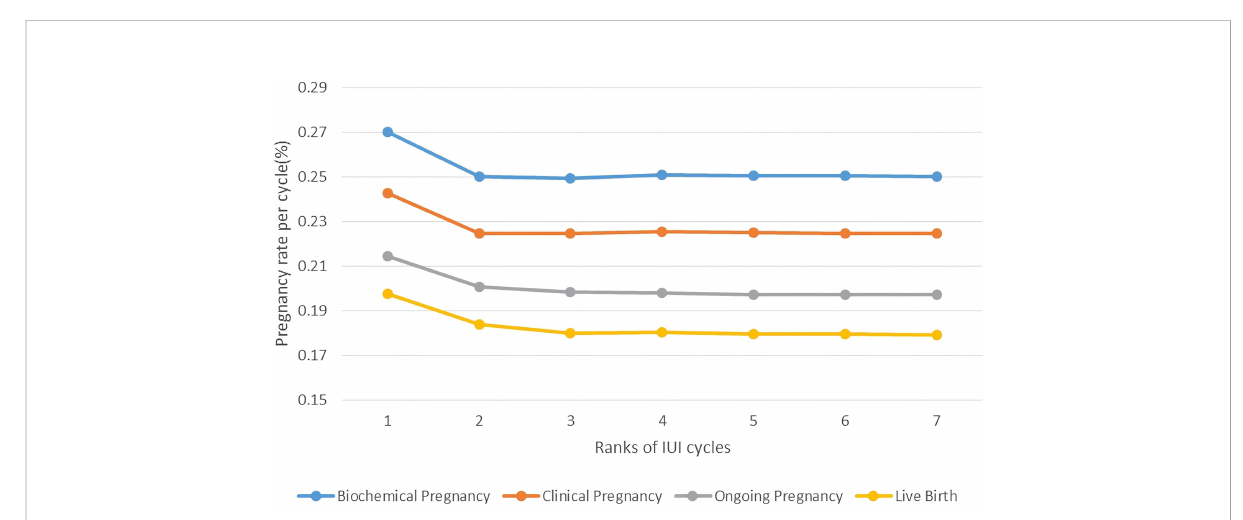
FIGURE 2 Pregnancy rate per cycle of PCOS patients undergoing different attempts of IUI in line charts. Pregnancy outcomes were as follows: biochemical pregnancy, clinical pregnancy, ongoing pregnancy, and live